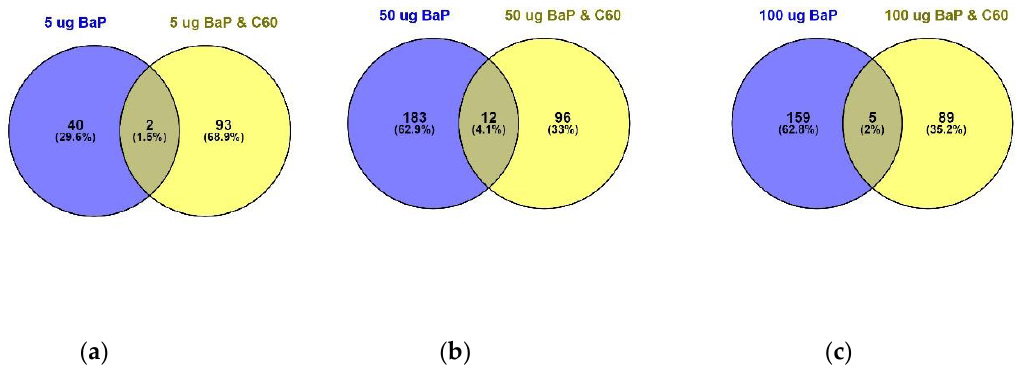
Figure 6. Venn diagram visualising the overlap between 5 µg/L ( a ), 50 µg/L ( b ) and 100 µg/L ( c ) of B[a]P with a mixture solution containing the same B[a]P concentrations in addition to 1 mg/L of C 60 following 24 h exposure. Overlap is based on p < 0.05 and FDR set at 1%.